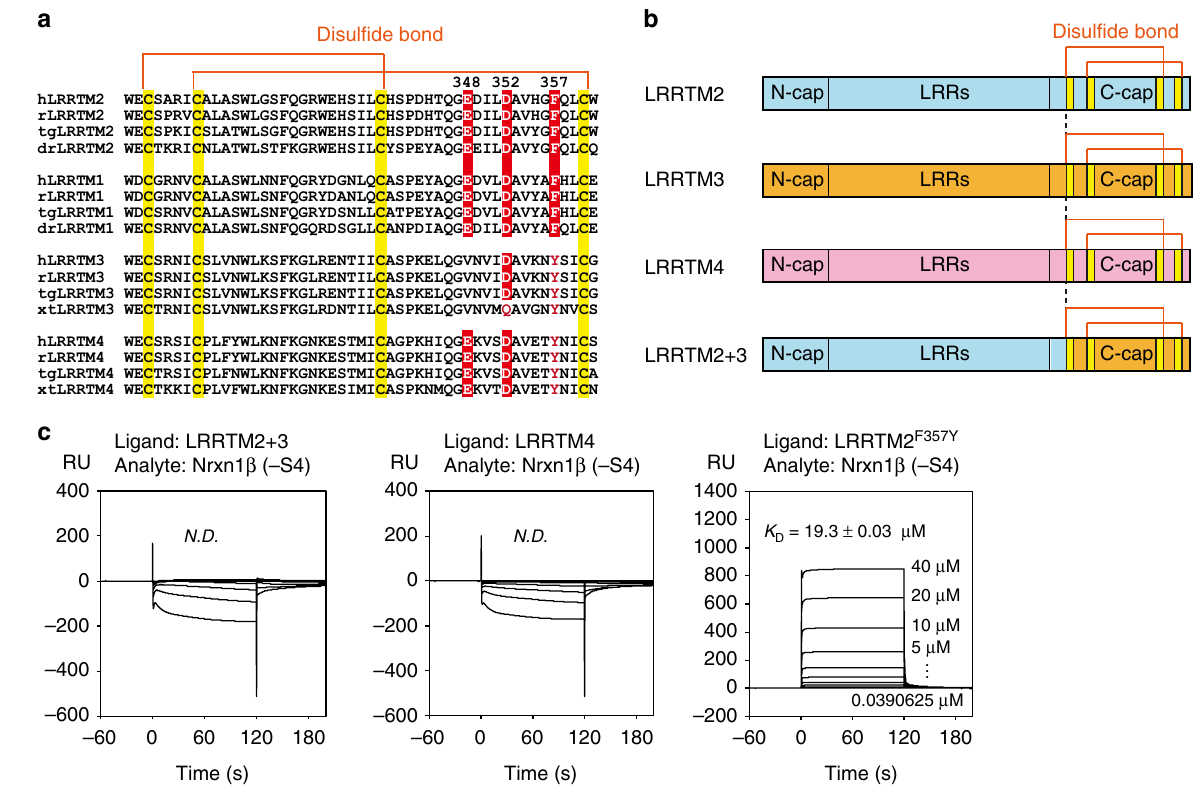
Fig. 5 Selective binding of Nrxn1 β to LRRTM1 and LRRTM2. a Sequence alignment of the C-terminal caps of LRRTM1 – LRRTM4. Three key residues of LRRTM2 for the interaction with Nrxn1 β (i.e., Glu348, Asp352, and Phe357) and the corresponding conserved residues of LRRTM1, LRRTM3, and LRRTM4 are highlighted in red with white letters. The cysteine residues forming disul fi de bonds are highlighted in yellow. h, Homo sapiens ; r, Rattus norvegicus ; tg, Taeniopygia guttata ; dr, Danio rerio . b Schematic diagrams of LRRTM2, LRRTM3, LRRTM4, and LRRTM2 + 3. LRRTM2 + 3 is an LRRTM2-based chimera where the C-terminal region starting at the fi rst disul fi de bond in the C-terminal cap (C-cap) of LRRTM2 is replaced by the corresponding region of LRRTM3. c SPR analyses of the interactions of Nrxn1 β ( – S4) with LRRTM2 + 3, LRRTM4, and LRRTM2 F357Y . Sensorgrams at different concentrations